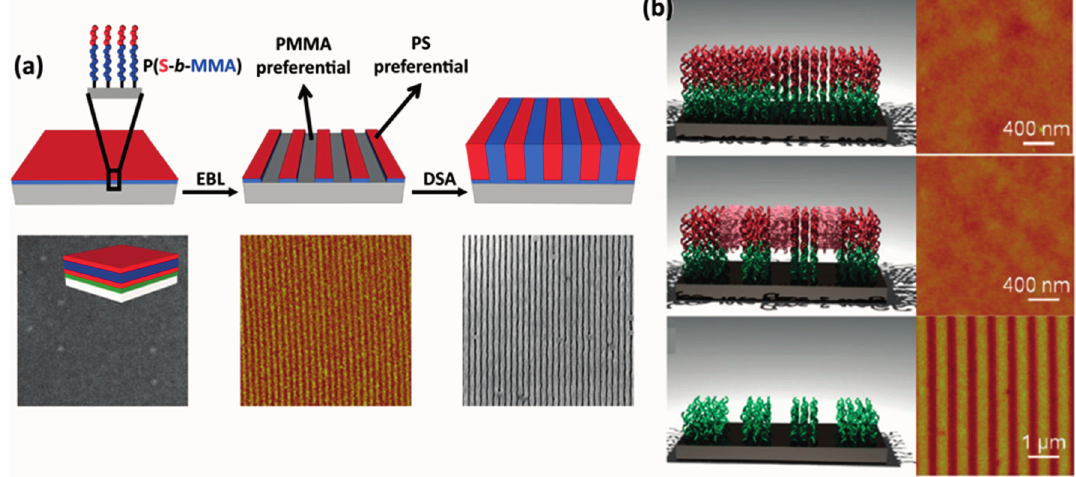
Figure 6. ( a ) Schematic illustration of the use of surface-anchored P(S- b -MMA) brush to fabricate chemical patterns for directed assembly of BCP. Corresponding SEM and Atomic Force Microscope (AFM) images are shown for each step. The inset schematic in the left SEM image represents parallel lamellae microdomains in the P(S- b -MMA) thin film (Reproduced with permission from Reference [114], Copyright 2012, American Chemical